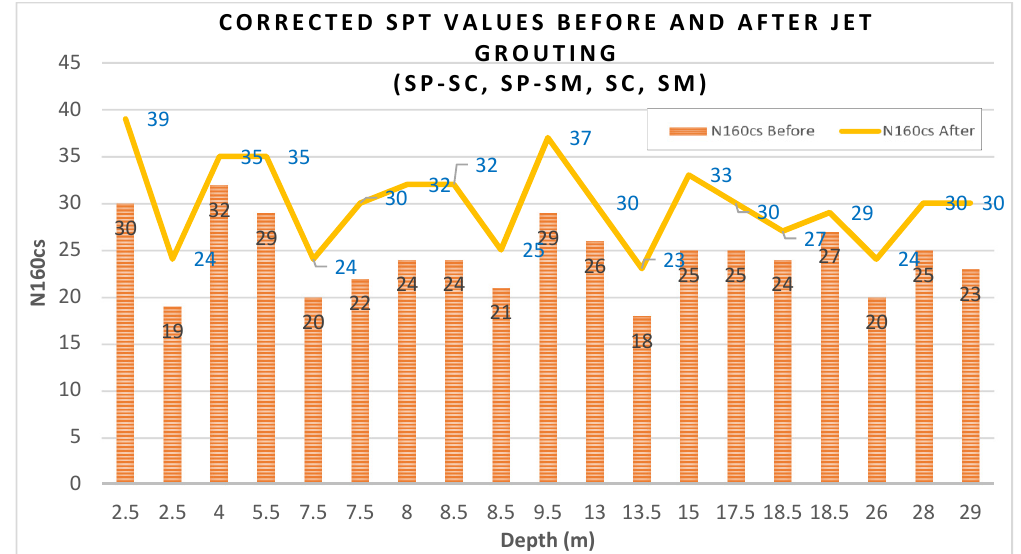
Figure 7. Corrected SPT values before and after jet grouting using micropiles in the soil profile containing SP-SC, SP-SM, SC, and SM.